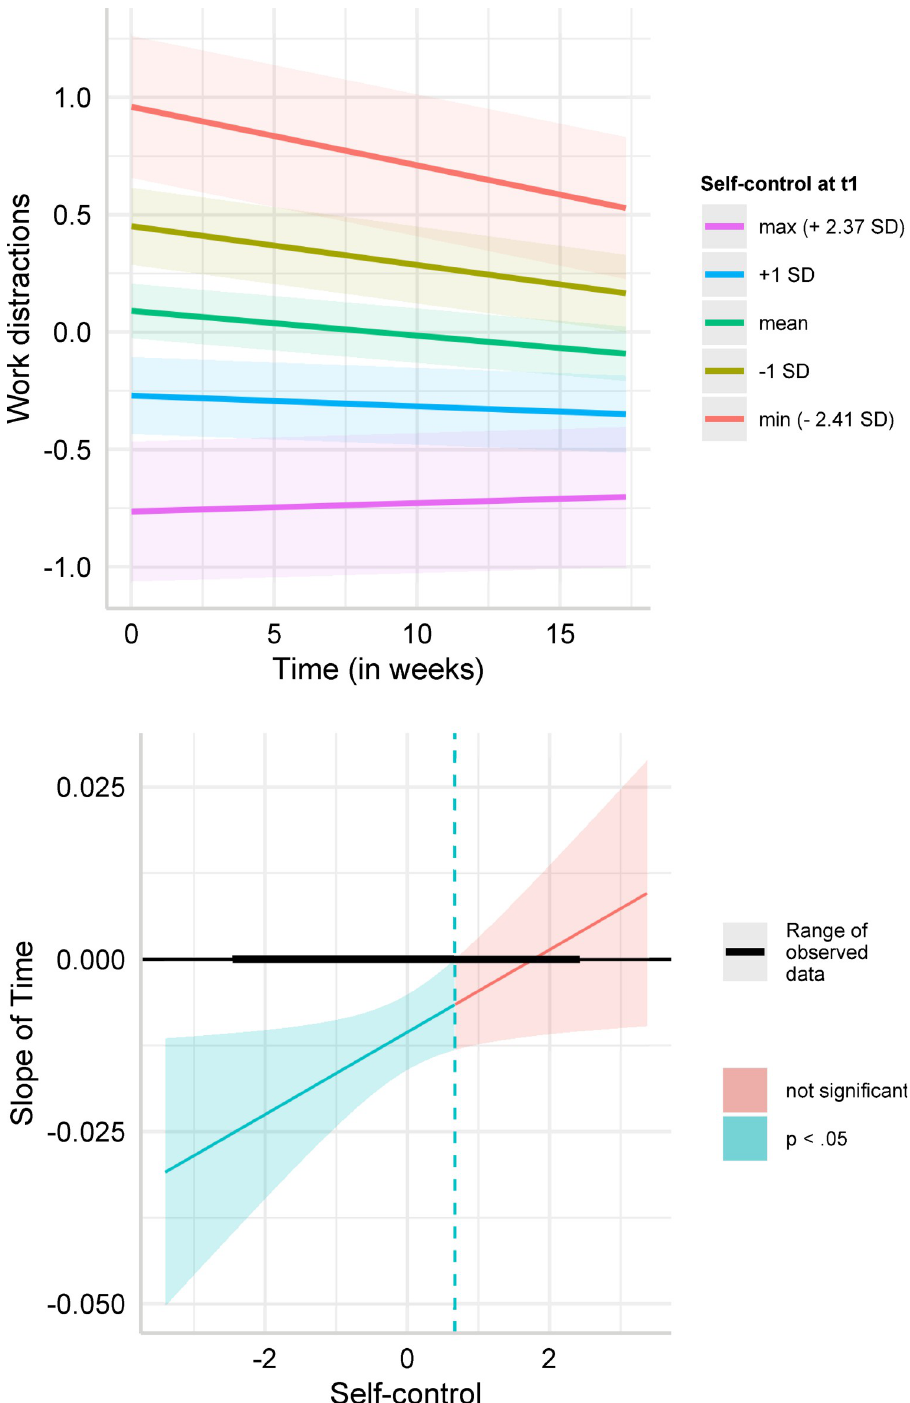
Fig 3. A. Predicted values of work distractions. Simple slope estimates for Model 1 (dependent variable: work distractions) in Table 4. The figure depicts predicted values of work distractions (standardized around 0) over time for low self-control (-1 SD below mean), average self-control, high self-control (+1 SD above mean) individuals, minimum self-control in the sample (-2.41 SD), and maximum self-control in the sample (2.37 SD). B. Johnson-Neyman intervals for work distractions. Johnson-Neyman intervals for the simple slope estimates for Model 1 (dependent variable: work distractions) in Table 4. The figure depicts the estimated slope of time for each level of trait self-control (standardized around 0) and highlights for which values of trait self-control the simple slope estimate is significant.